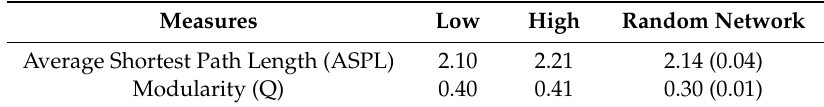
Table 5. Empirical and random measures of the Gf semantic